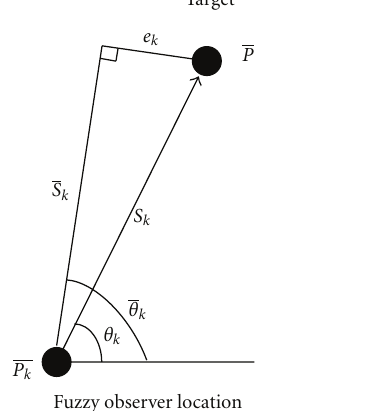
Figure 2: Fuzzy geometric relationship between a sensor and a